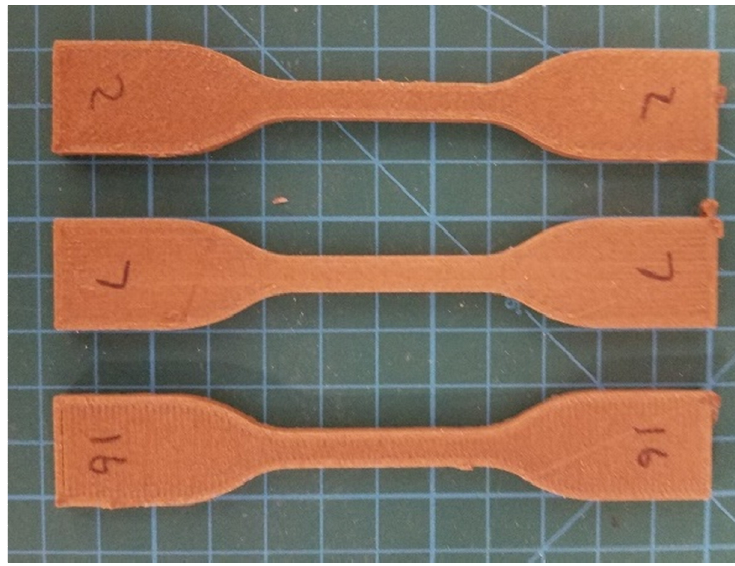
Figure 2. Example of representative printed part quality.